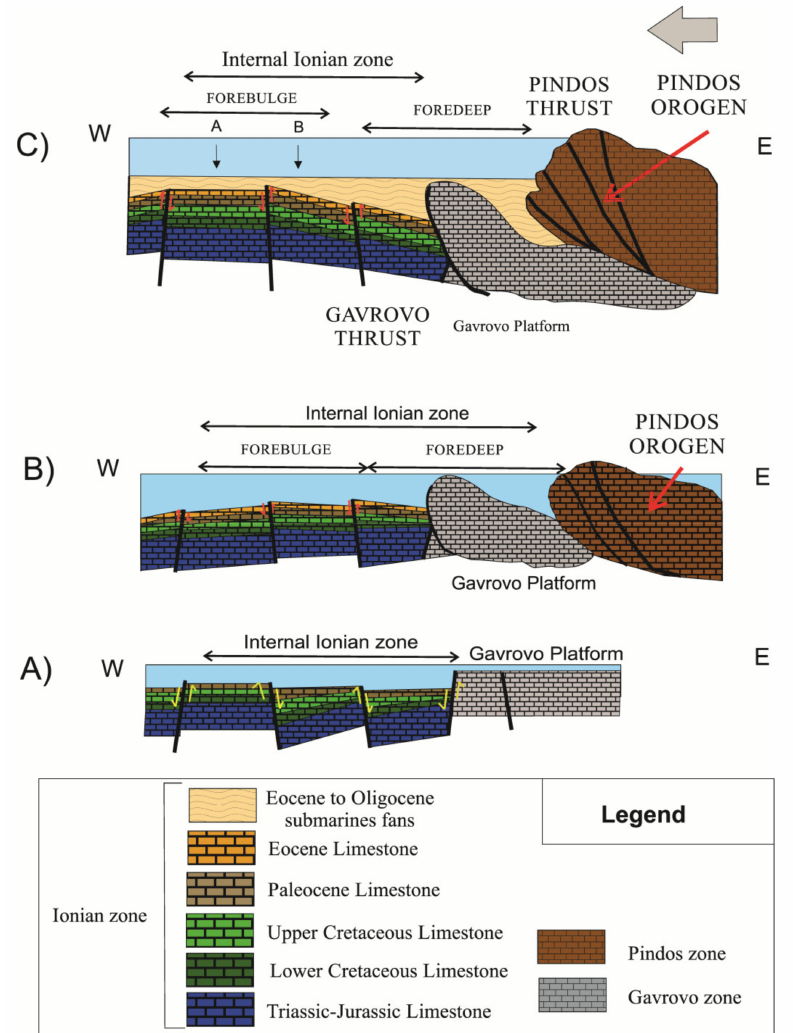
Figure 25. Evolutionary model of the studied part of the Ionian basin, illustrating the Maastrichtian- lower Eocene depositional conditions in the eastern part of the Ionian basin represented by three cross-sectional evolutionary stages. Stage ( A ) shows the depositional conditions during the rifting period (Jurassic-Paleocene). Stages ( B ) and ( C ) show the gradual formation and evolution of Pindos foreland basin during the compressional regime (Lower Eocene). Notice the gradual development of the forebulge